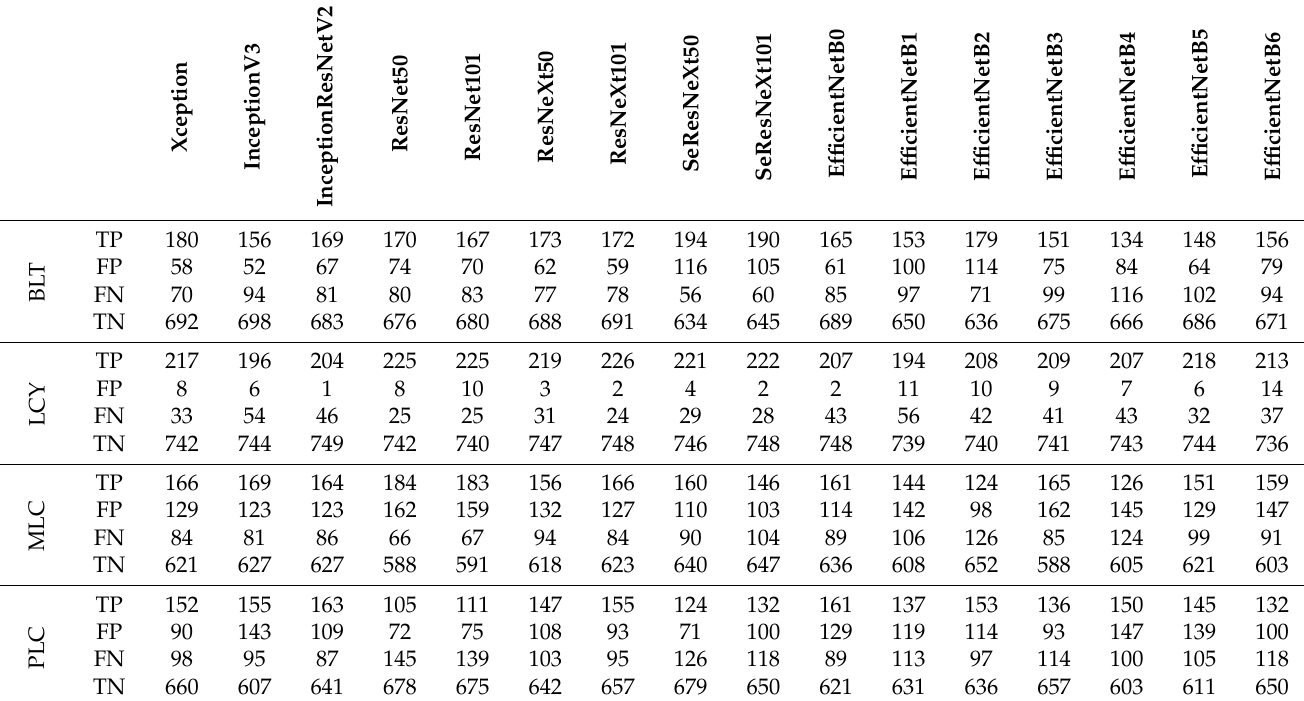
Table 3. True positive, false positive, false negative, and true negative values for 4-class classification in 16CNNs. BLT: benign liver tumor, LCY: liver cyst, MLC: metastatic liver cancer, PLC: primary liver